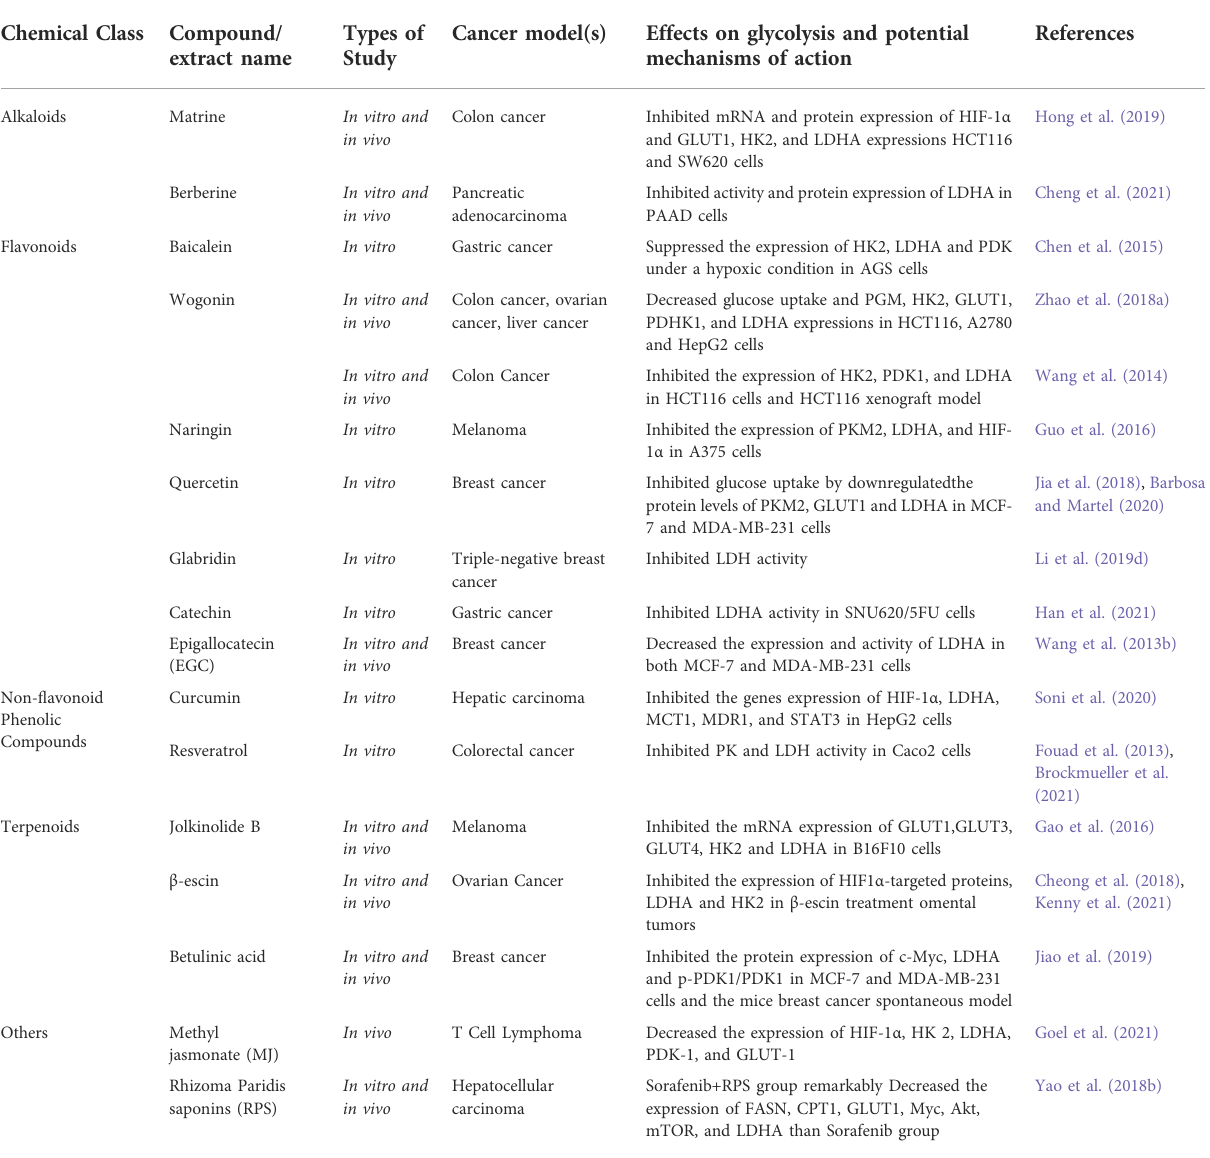
TABLE 4 Natural compounds target lactate dehydrogenase